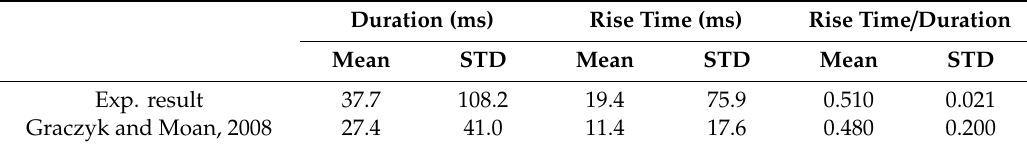
Table 4. Comparison of experimental results and actual sloshing test in temporal pattern.